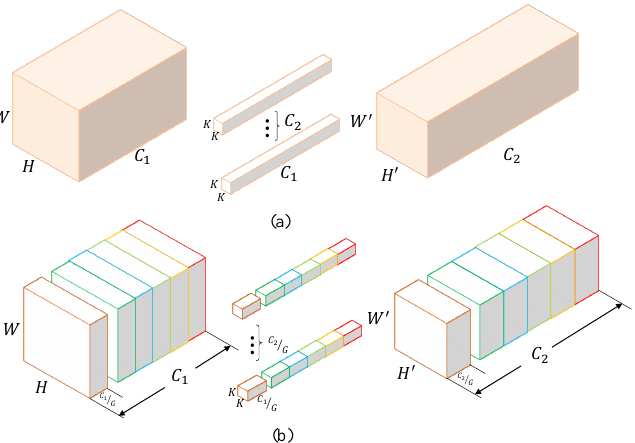
Figure 3. Standard convolution and group convolution. ( a ) The standard convolution has C 2 kernels, and every channel of kernels is the same as input features. ( b ) Group convolution divides channels of input features into G groups, and every group corresponds to C 2 kernels with size K × K × C 1 Group convolution significantly reduces computational complexity and the number of